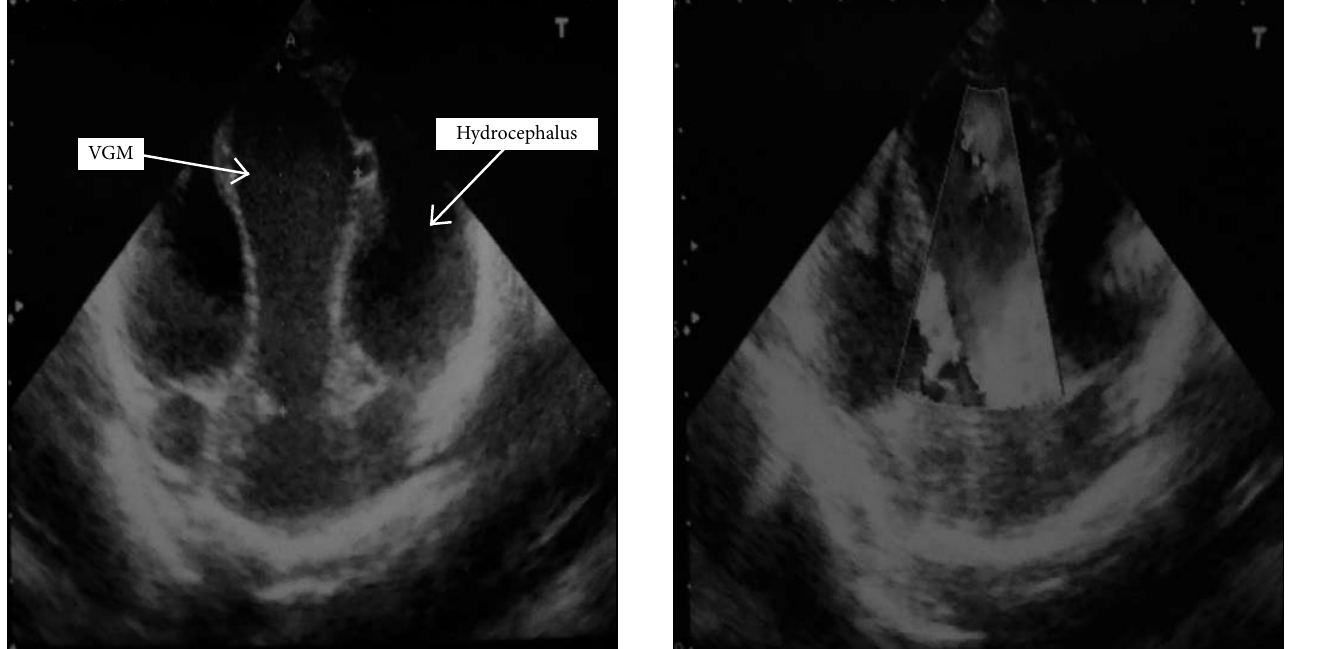
Fig. 3. Coronal cranial ultrasound demonstrates enlarged central vein of Galen with increased blood flow on Doppler study (left) and massive hydrocephalus with no brain parenchyma.